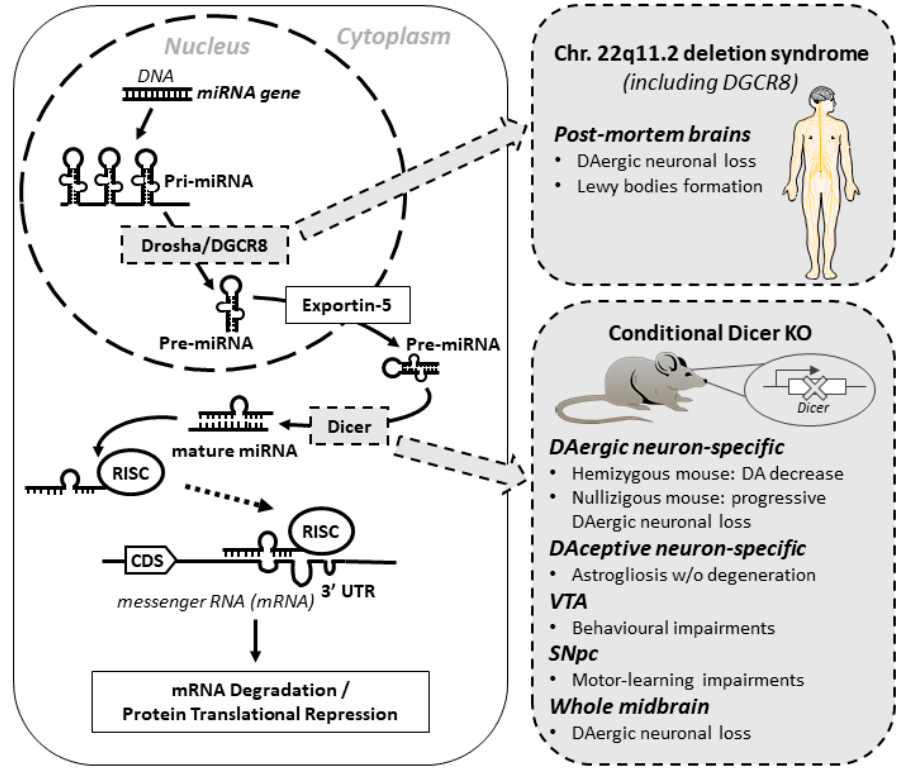
Figure 1. Biogenesis pathways of microRNAs and their dysregulations in Parkinson’s disease (PD). On the left panel, schematic representation of the intracellular miRNA canonical biogenesis, starting with transcription of pri-miRNA. The pri-miRNA is processed in the nucleus to pre-miRNA by the microprocessor complex (Drosha and DGCR8). The pre-miRNA is then exported via Exportin-5 into the cytoplasm where it is further cleaved by Dicer. Finally, the mature guide strand is assembled with members of the Argonaute family to form a functional RNA-induced silencing complex (RISC). On the right panels, ablation of DGCR8 (human) and its effect on brain ( top right ) and temporal and spatial controlled ablation of Dicer (mouse) and its effect on different brain areas ( bottom right ). knockout (KO); ventral tegmental area (VTA); coding sequence (CDS); substantia nigra pars compacta (SNpc).